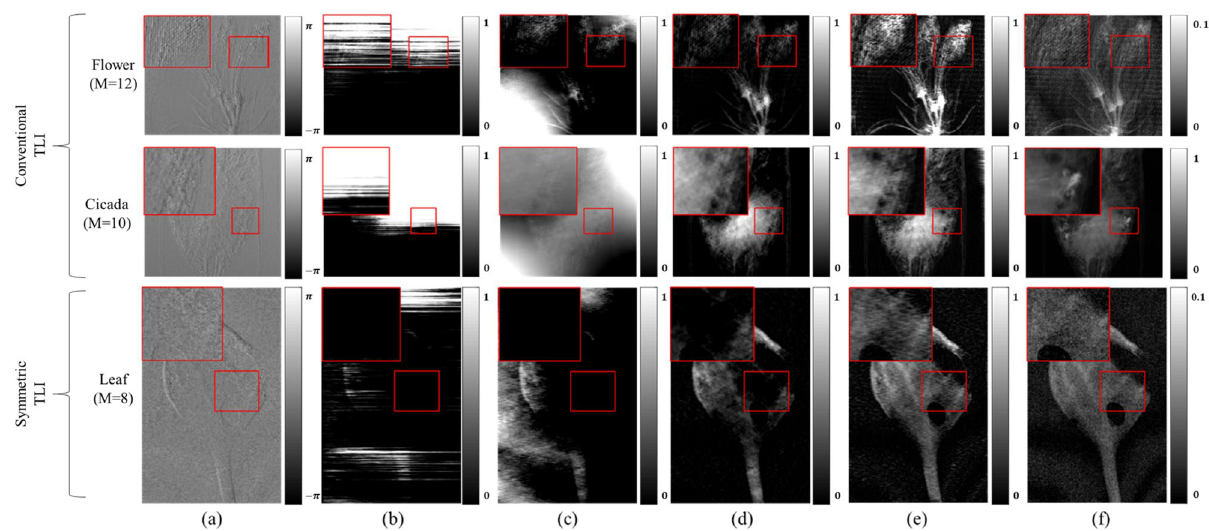
Figure 5. The X-ray grating interferometer comparison results. ( a ) DPCI, ( b ) direct integration, ( c ) WF filtering, ( d ) iterative method, ( e ) the proposed method, ( f ), transmission. The display windows are same for ( b – e ), and the display window of the first and third images of ( f ) are [0, 0.1], and the second is [0, 1], respectively. The variable M denotes the total phase stepping number. The red rectangle regions are selected